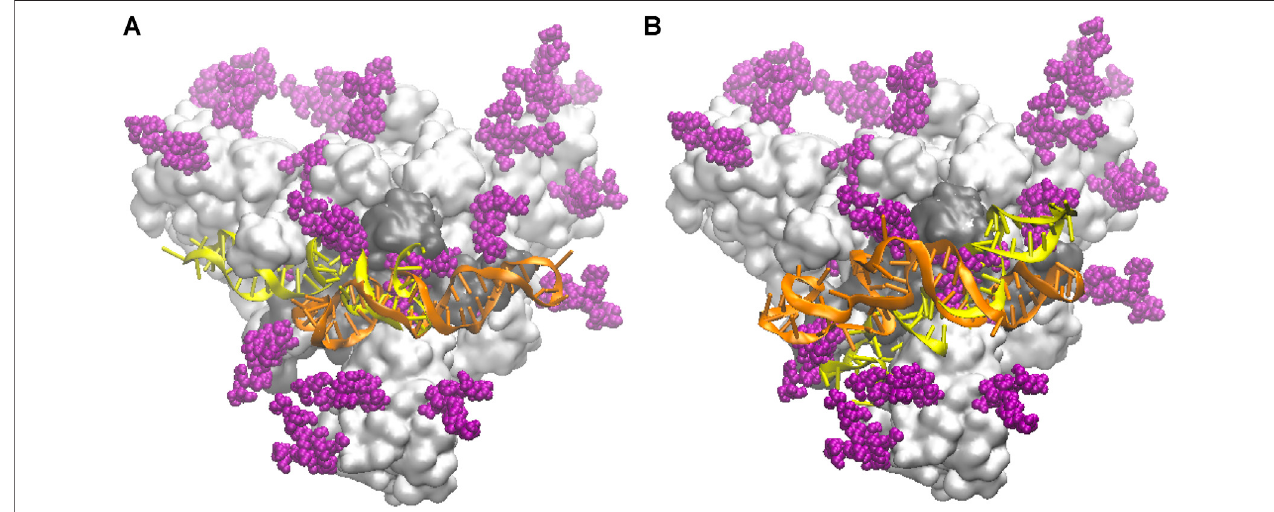
FIGURE 2 | Schematic of the initial docked DNA/S-protein structures from HADDOCK. The trimer head of the S-protein is shown as a light grey surface, slightly tiltedbackwithrespecttothemain(central)axisforbetterview;theRBDincontactwithDNAaptamersisthedarkgreyarea;glycansaredepictedbypurplespheres;the DNAconformationsaresuperposed,inyellowtheonefortheNGprotein,inorangetheonefortheFGprotein. (A) Theshorter apta1 DNAboundtotheS1-RBDdomain. (B) The longer apta2 bound to the S1-RBD domain.